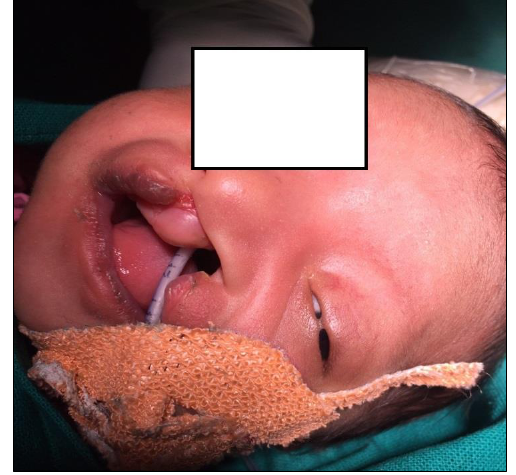
Figure 1: Left eye shows an adhesion between eye lids. He was screened for late onset neonatal sepsis and started on cefotaxime and amikacin. Septic screen parameters were negative. His general condition and vitals improved after 72 hours of hospitalisation. The adhesion was divided with Castroviejo corneoscleral scissors by cutting at its base, flush with the lid margin. The adhe- sion as separated first from the upper lid mar- gin followed by the lower lid margin. After the adhesion was removed reassessment of the